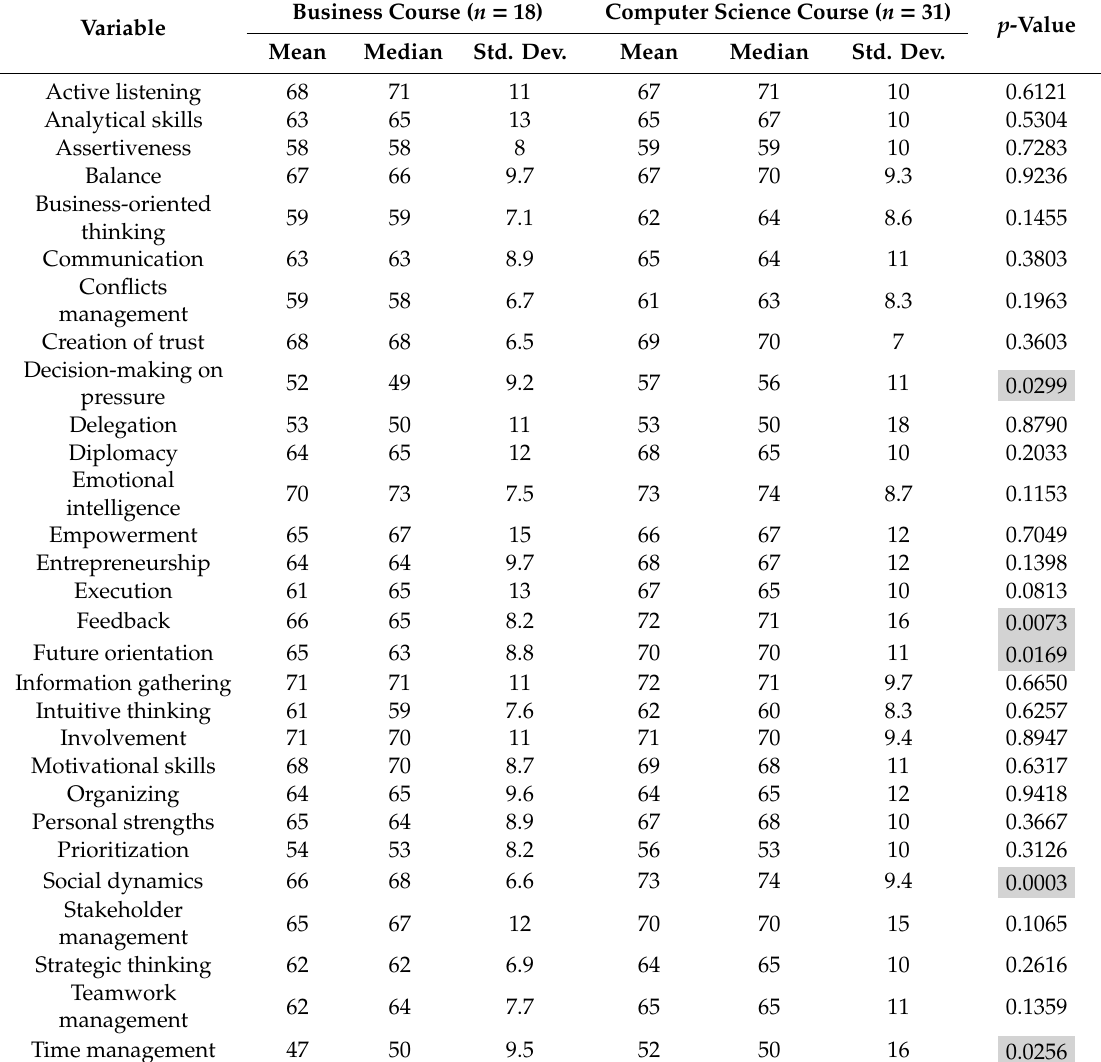
Table 5. Students’ performance in FLIGBY considering MAP